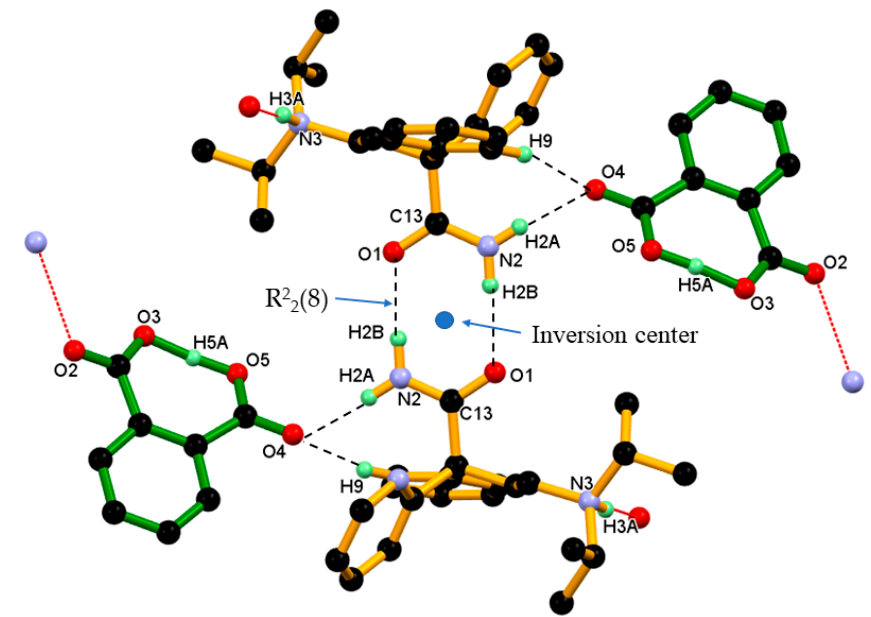
Figure 9. Dimeric unit of DPA_PA salt in crystal. Dotted lines indicate the non-covalent interaction (hydrogen atoms not involved in the hydrogen bonding were removed for clarity).